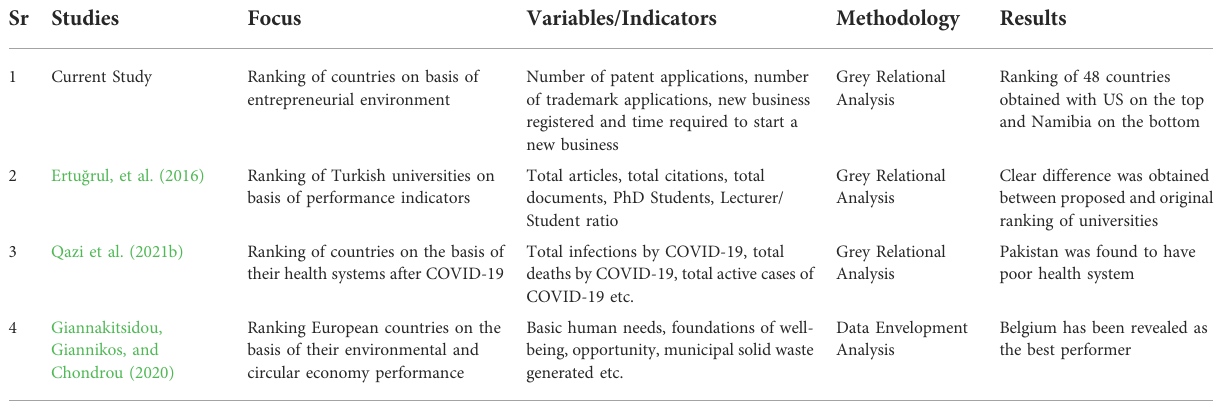
TABLE 10 Contrasting results of the study with some studies from existing